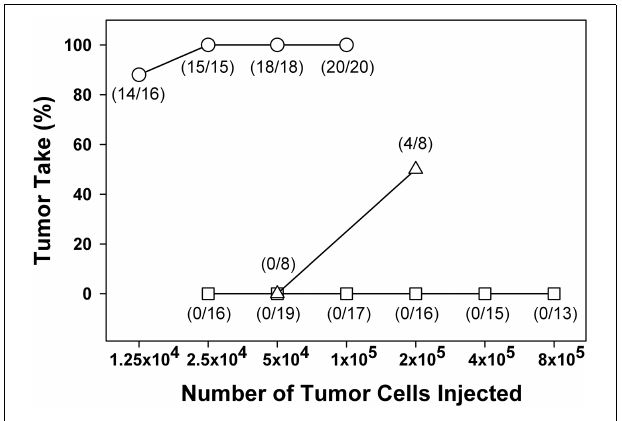
FIGURE 2 | Resistance of cured mice to reinoculation of tumor cells. Mice cured of their primary tumor after irradiation alone ( Δ ) or after treatment with CpG ODN 1826 plus irradiation ( (cid:2)(cid:2)(cid:2) ) were reinoculated with FSa tumor cells 100–120 days after local tumor irradiation. Age-matched ◦ untreated mice were used as controls ( ). Mice were injected s.c. on the abdomen with graded doses of FSa tumor cells and tumor takes observed for up to 2 months after inoculation. Numbers in parentheses , tumor takes over total injection sites. Reprinted by permission from the American Association for Cancer Research (Mason etal.,